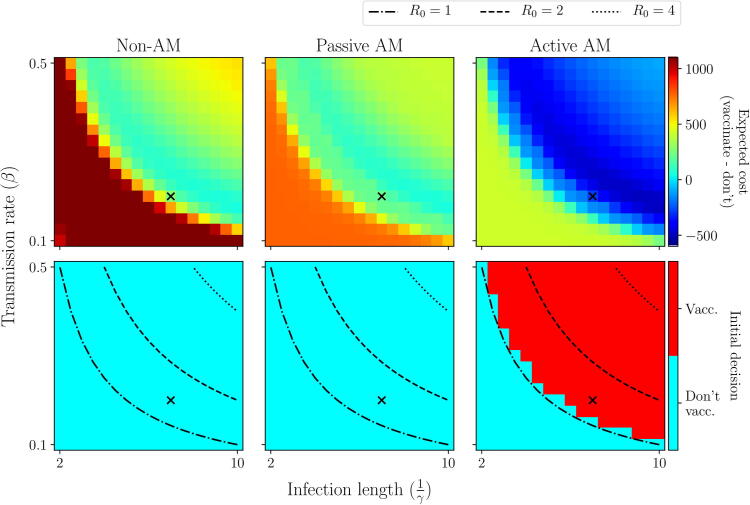
Scenario 1: Initial decision made under each approach, varying epidemiological parameters. We vary the epidemiological parameters describing transmission (β) and recovery/removal (γ). Top row: difference in expected cost between vaccinating initially or not, as viewed under each approach. Bottom row: initial decision made under each approach: vaccinate (red) or not (blue). Black crosses represent the default values used in scenario 1 (Table A.2). Lines of constant R0 are identified with black lines.